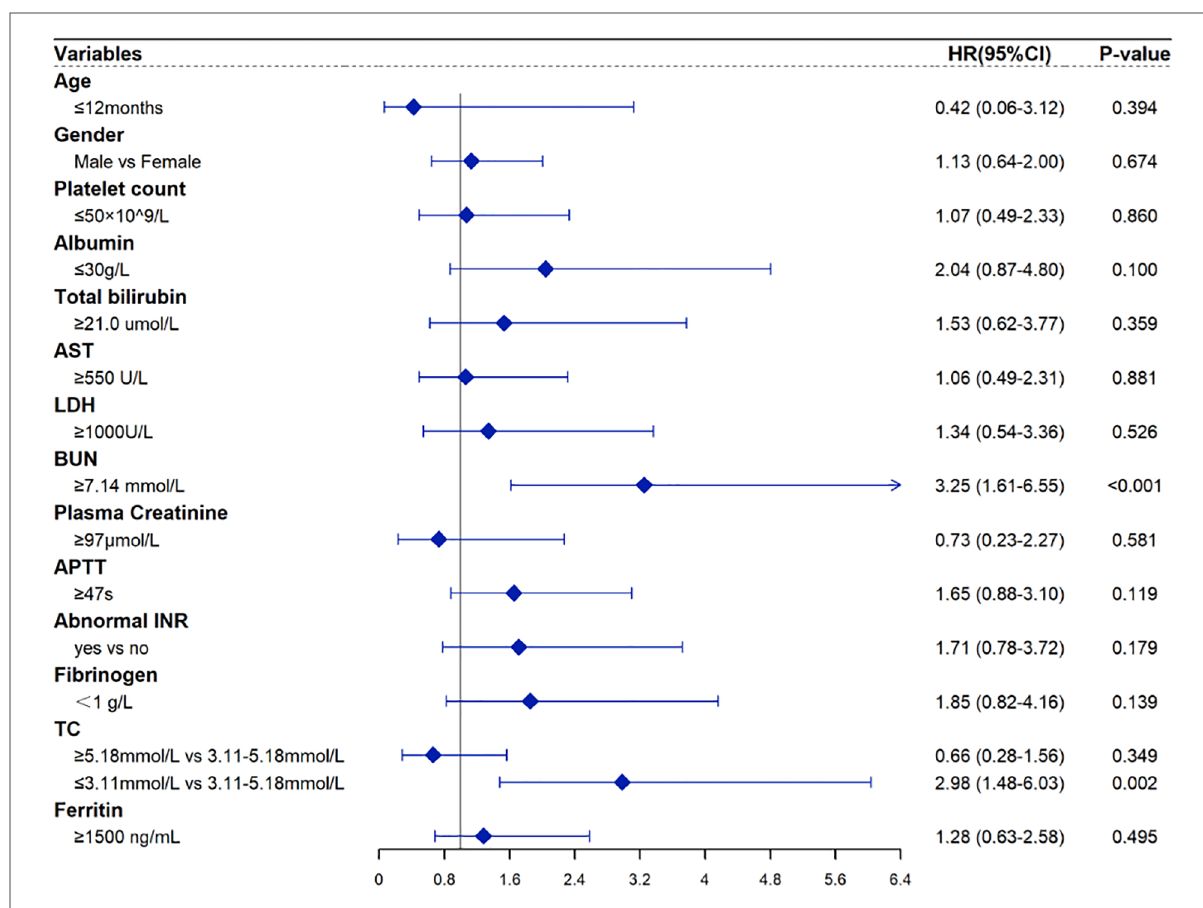
FIGURE 8 Forest plots for the multivariate Cox regression analysis with only complete HLH